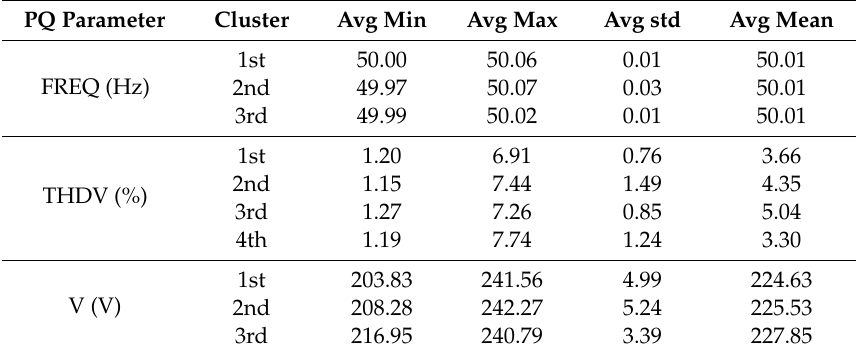
Table 6. Statistical description of the PQ parameters of the obtained clusters at SoC 100%.